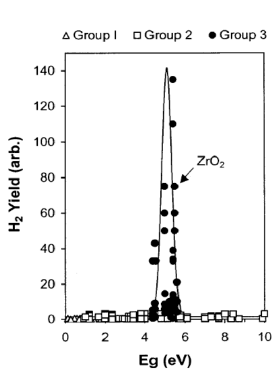
Figure 6. Hydrogen chemical radiation yield versus bandgap of various oxides (E bg ): Group 1 represents inhibitor metal oxides (e.g., MnO 2 , Co 3 O 4 , CuO, and Fe 2 O 3 ), Group 2 represents indifferent metal oxides to γ -radiolysis (e.g., MgO, CaO, SrO, BaO, ZnO, CdO, Cu 2 O, NiO, Cr 2 O 3 , Al 2 O 3 , CeO 2 , SiO 2 , TiO 2 , Nb 2 O 5 and WO 3 ), and Group 3 represents metal-oxide promoters (Ga 2 O 3 , Y 2 O 3 , La 2 O 3 , Nd 2 O 3 , Sm 2 O 3 , Eu 2 O 3 , Gd 2 O 3 , Yb 2 O 3 , Er 2 O 3 , HfO 2 , and ZrO 2 ) for the γ radiolysis of adsorbed water. For more